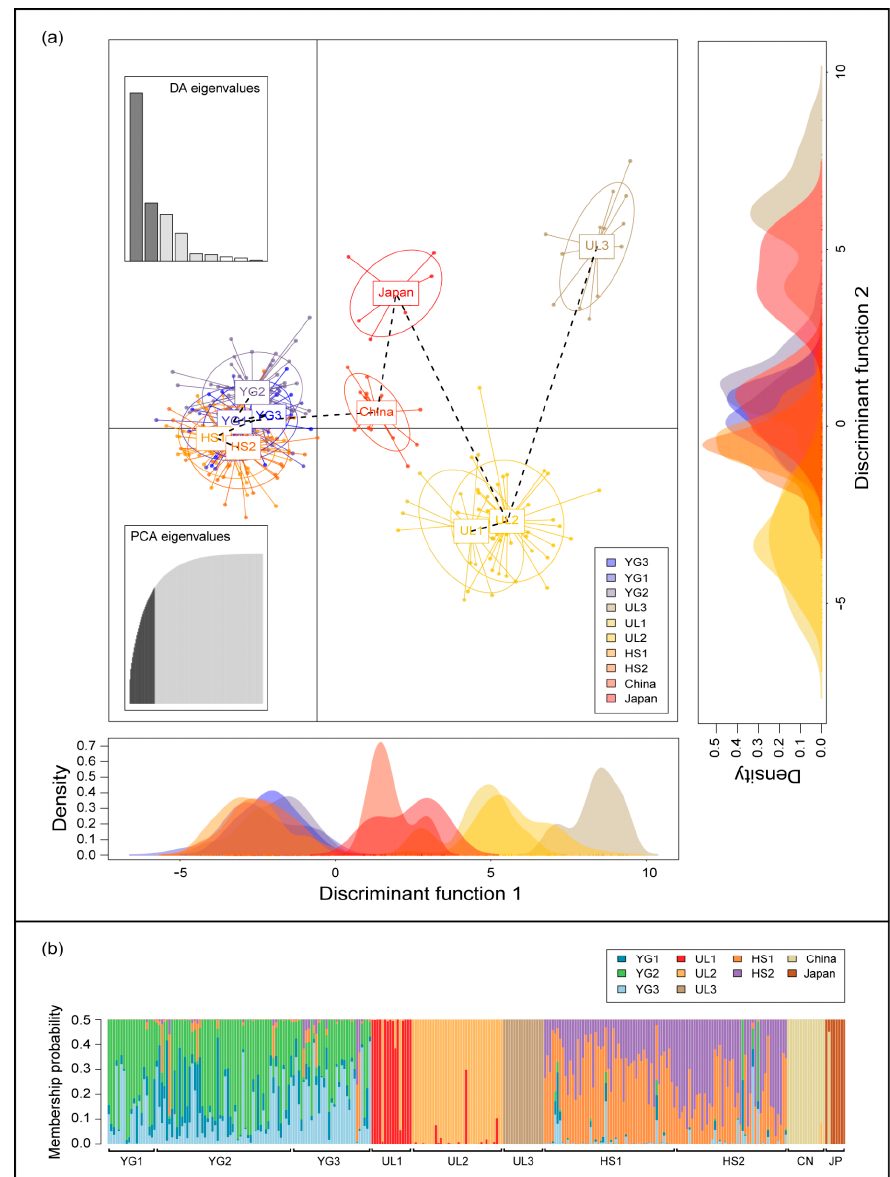
Figure 6. Population clustering analysis by discriminant analysis of principal components (DAPC). ( a ) Discriminant function 1 (DF1) explained 52.06% and DF2 explained 18.04% of the genetic variation in spring orchids from ten sites. Each node represents the genotype of a spring orchid connected to a centroid, was assigned based on the clustering of the DAPC scores. The dotted line represents the spanning tree among spring orchids from ten sites. ( b ) Membership probability of DAPC determined that the sampled individuals were optimally clustered into seven groups, whereas the sampling sites of YG and HS were clustered into each two